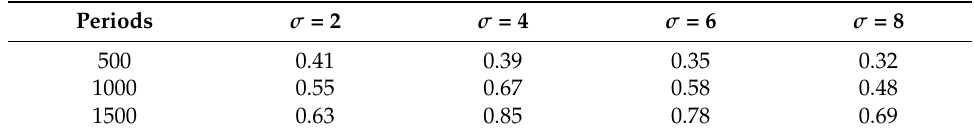
Table 2. Impact of shrinking factor σ on scheduling